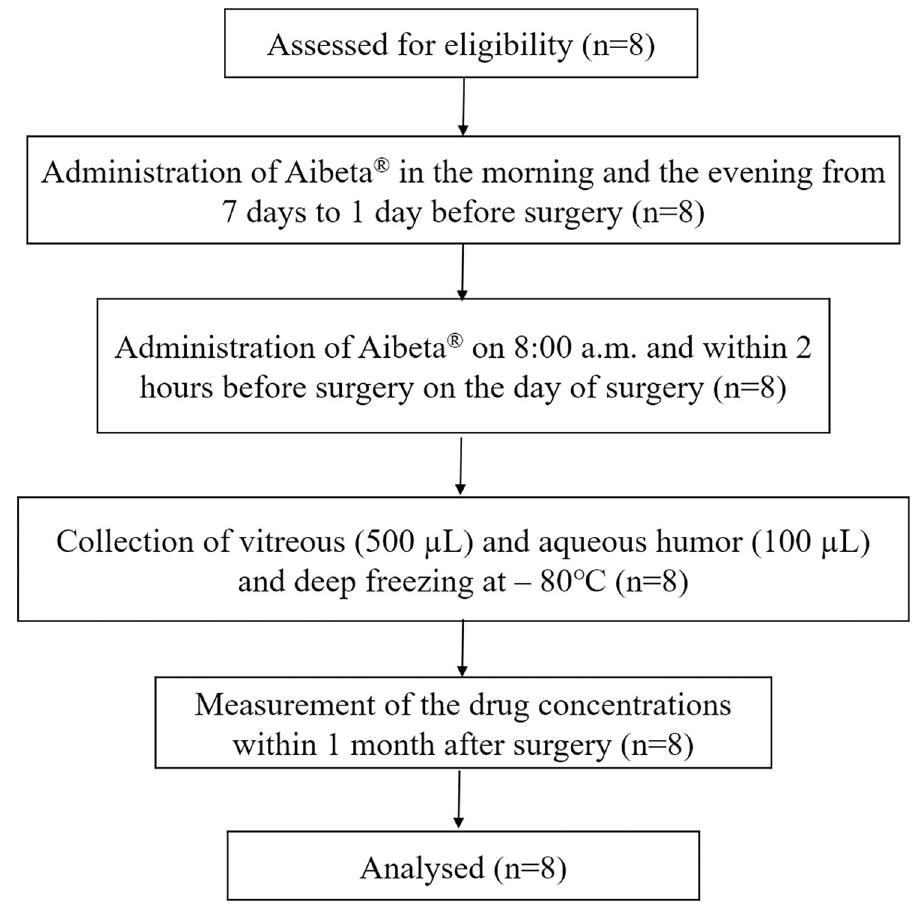
Fig 1. CONSORT flow diagram.